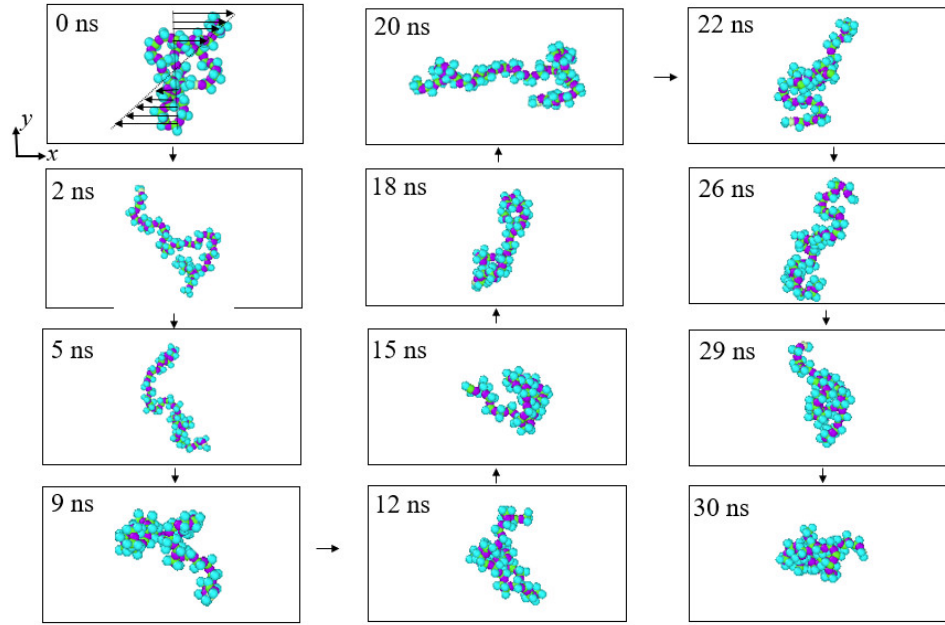
Figure 6. Snapshots of a polymer molecule in the ns36np15 solution at N = 200.